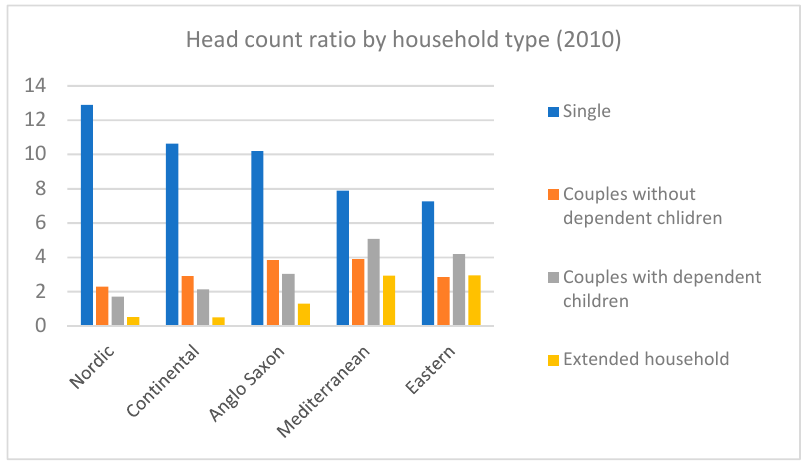
Figure 6. Source: our elaboration on Eurostat data. Head count ratio by household types (2019)